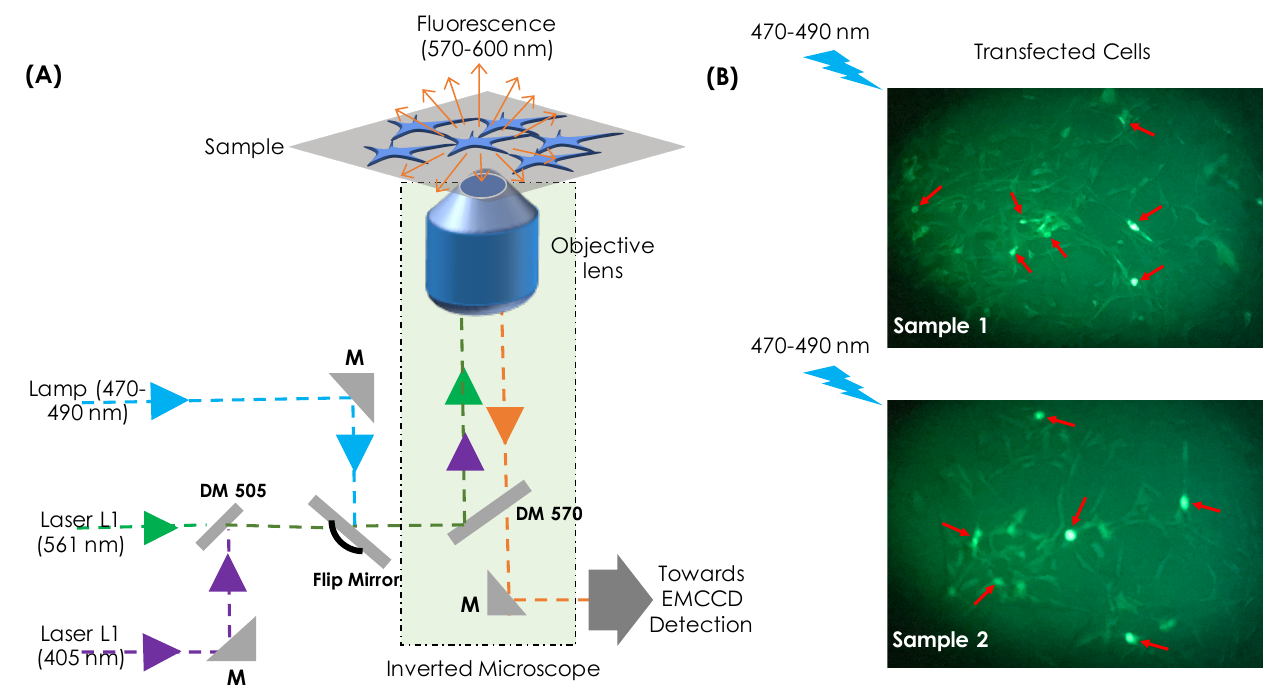
Figure 1. ( A ) Schematic diagram of the developed optical super-resolution imaging system for studying molecular clusters, ( B ) Dendra2-HA transfected cells where strong transfected cells appear bright and are indicated by a red